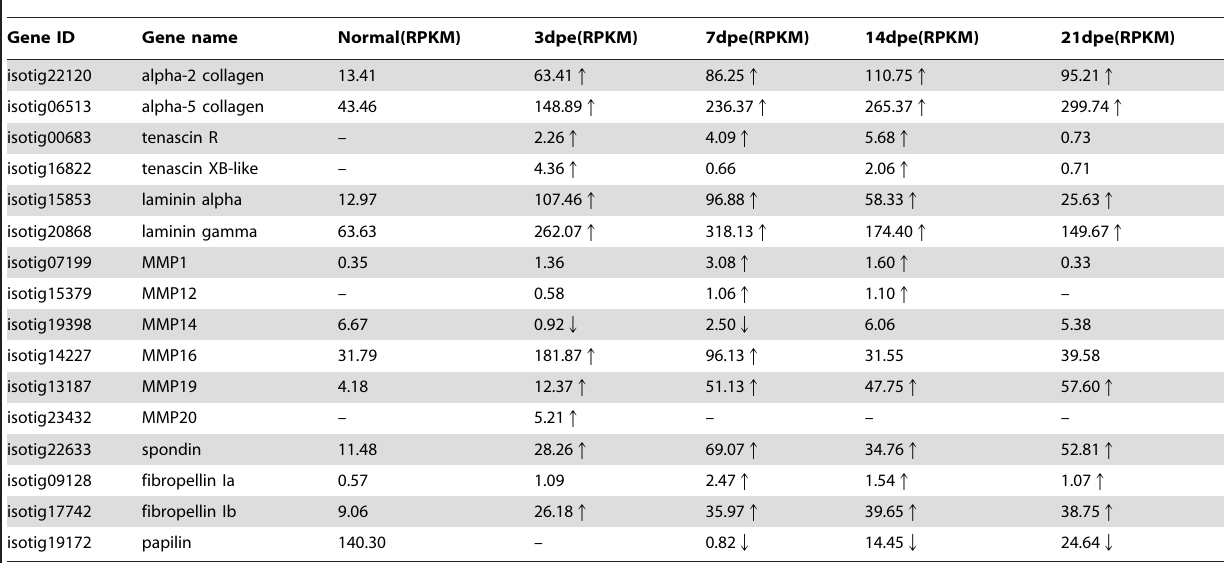
Table 11. Expression profile of ECM associated genes during intestine regeneration.